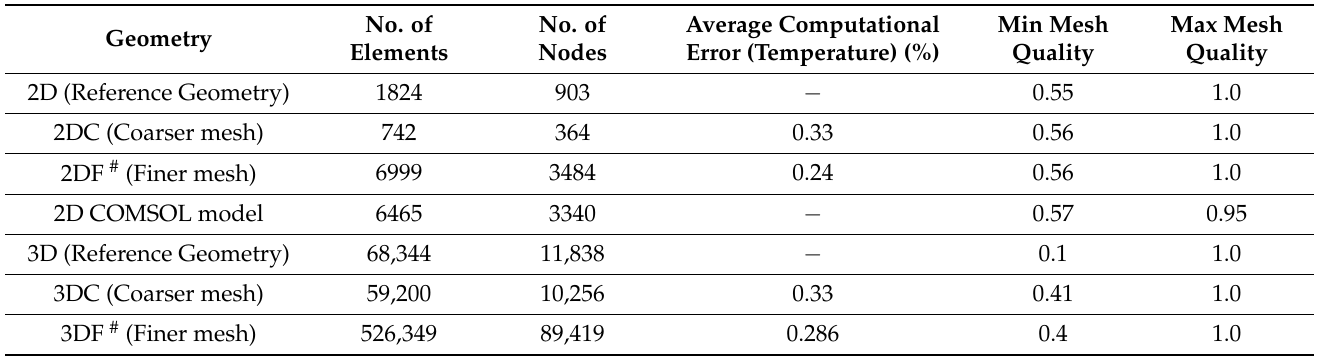
Table 2. Mesh information for the 2D and 3D CAD